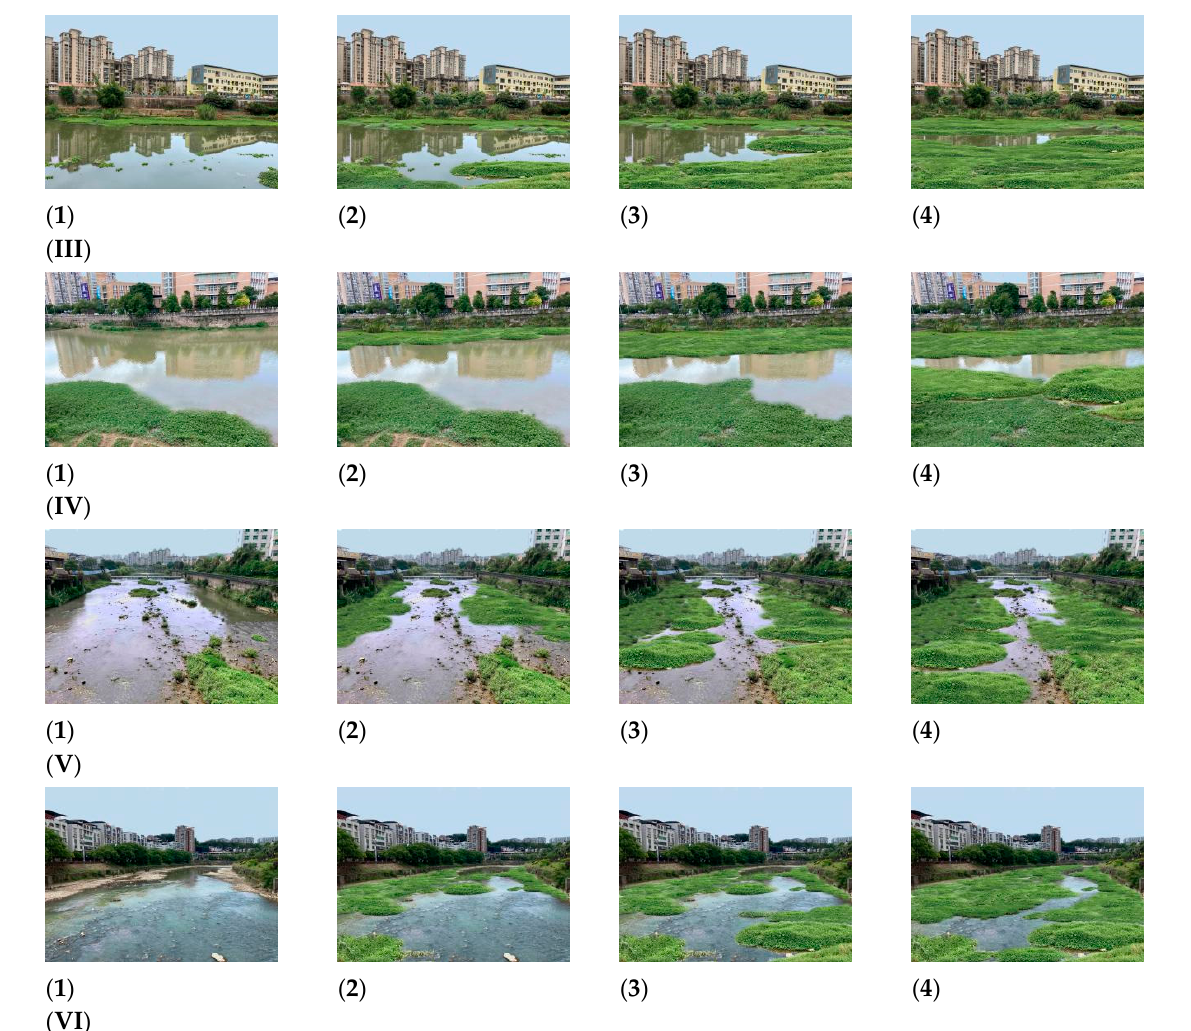
Figure A1. Six groups of images ( I – VI ) collected in this study, showing stream landscape variations due to changes in vegetation and water. ( I , II ) A cross-river view taken from the rubble dam upstream to downstream and the rubble dam downstream to upstream, respectively. ( III ) A cross-river view taken from upstream of the dam affected by backwater. ( IV ) A cross-river view taken from upstream of the dam affected by backwater. ( V ) A flow-axis view taken from the dam downstream when the rubber dam is raised. ( VI ) A flow-axis view taken from the rubber dam up-stream when the dam is lowered. Each ( 1–4 ) in the six groups showing the increase of visual greenery or decrease of visual water.